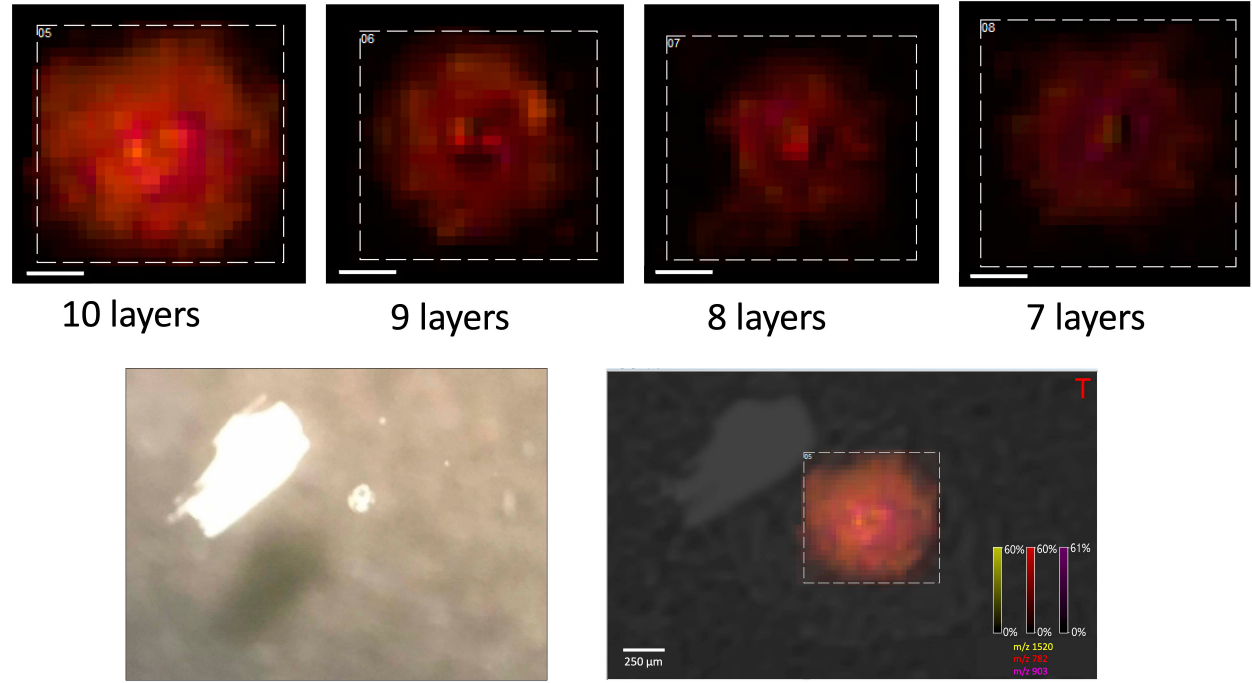
Figure 6. The MALDI-MSI picture of the oocyte obtained after covering oocytes with different numbers of the matrix layers, positive ionization mode, ( m / z 810, nozzle position: Z = 25), size bar: 200 µ m. Below it is presented the microscopic image of